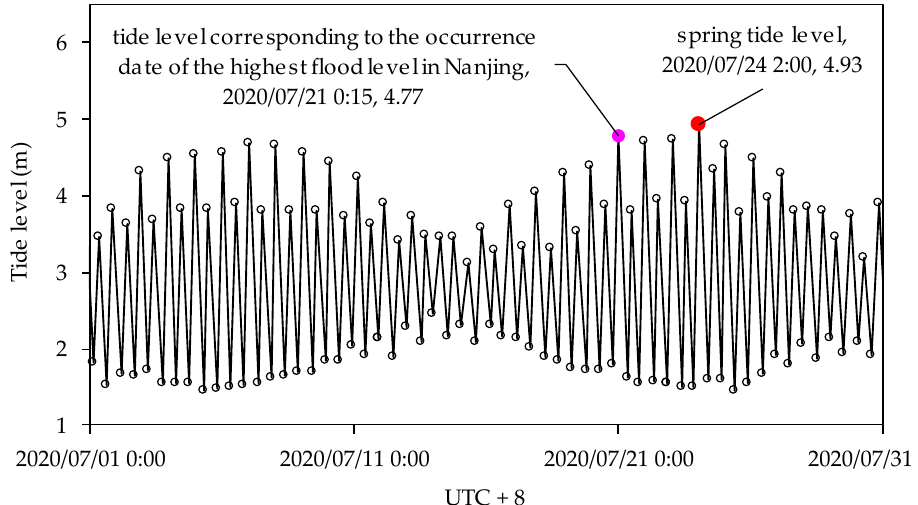
Figure 8. Tidal level process of Liuxiao gauge around the occurrence date of the extreme flood level at Nanjing.